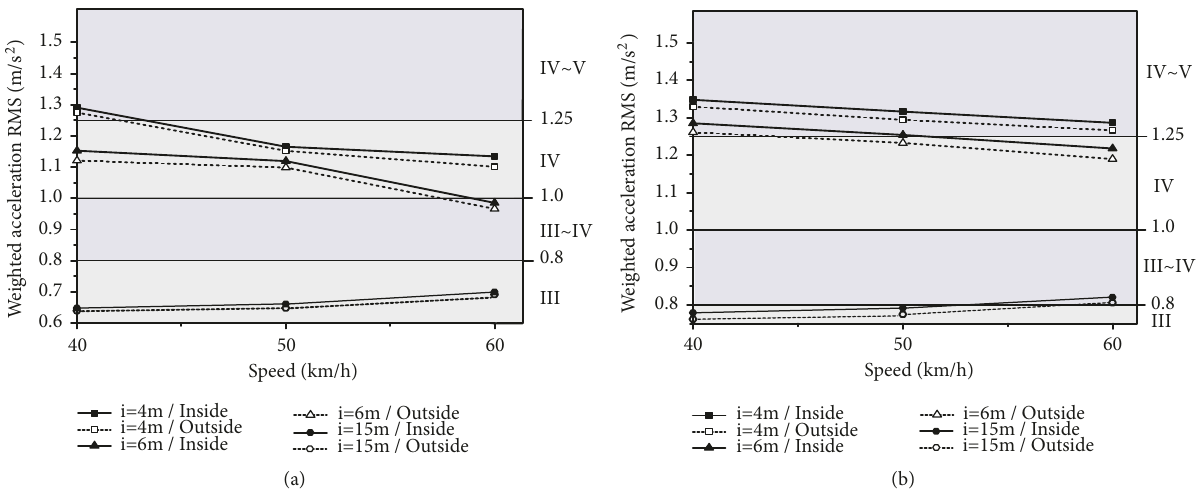
Figure 5: The combined total weighted accelerationRMS for the curved ramp section: (a) the curved ramp section (car); (b) the curved ramp section (semi-trailer